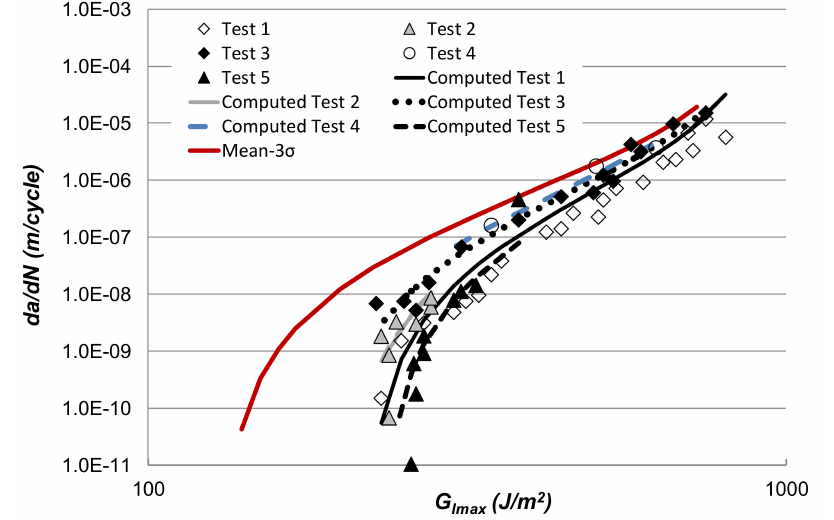
Figure 8. The measured [74] and computed Mode I da / dN versus G Imax curves for the rubber-toughened epoxy-film adhesive (“EA9628”). (The subscript I refers to Mode I (tensile-opening